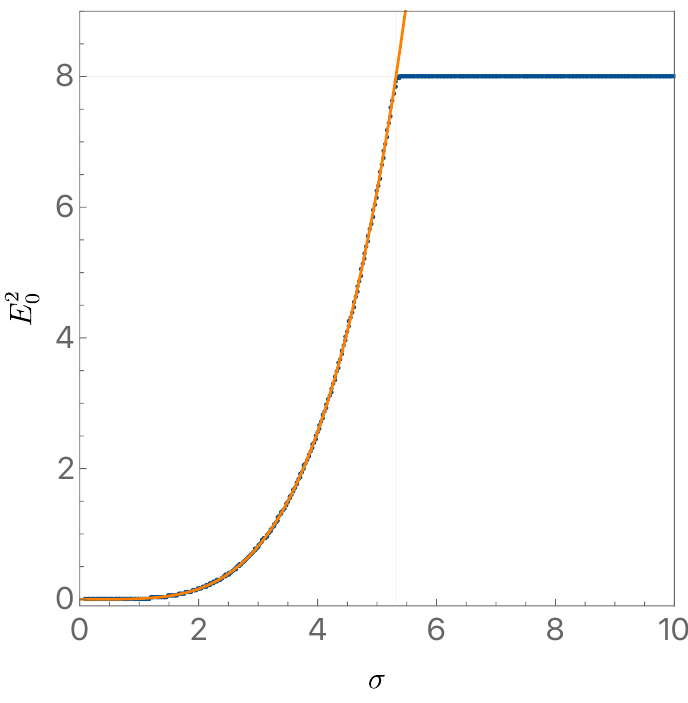
Figure 10: Tearing transition as a function of σ . Blue dots are numerical solutions “ 8. At large σ we see the to the (95) and (122) for x “ 10, γ “ 10 ´ 4 and M 2 0 « 8 (horizontal grey line). As usual solution for the quartic matrix model and E 2 ? 0 σ is lowered and crosses σ 2 “ xM “ 20 2, there is a first order phase transition 0 and E 2 goes like σ 4 { x 2 , which is indicated with the solid orange curve. Note that at 0 finite γ the transition is smoothed out, but becomes sharp as γ Ñ